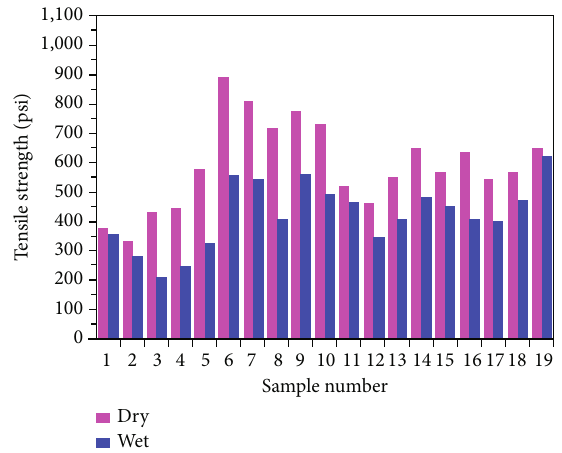
Figure 15: Comparison of the tensile strength of dry and wet Eagle Ford samples from Li et al.